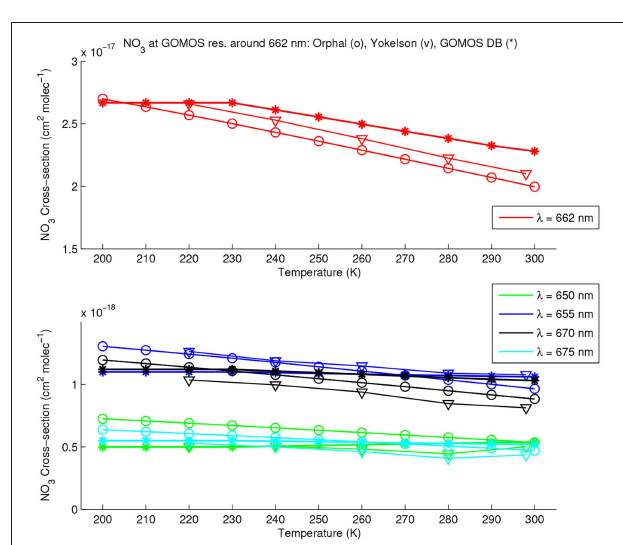
FIGURE 7 | Temperature dependence of the NO 3 absorption cross-section around the peak at 662nm, as provided by Orphal et al. (2003) (circles), Yokelson et al. (1994) (triangles), and GOMOS DB (stars). All spectra are considered at GOMOS spectral resolution. The color code used for the different wavelengths covering the range 650–675nm, is given in the legend.